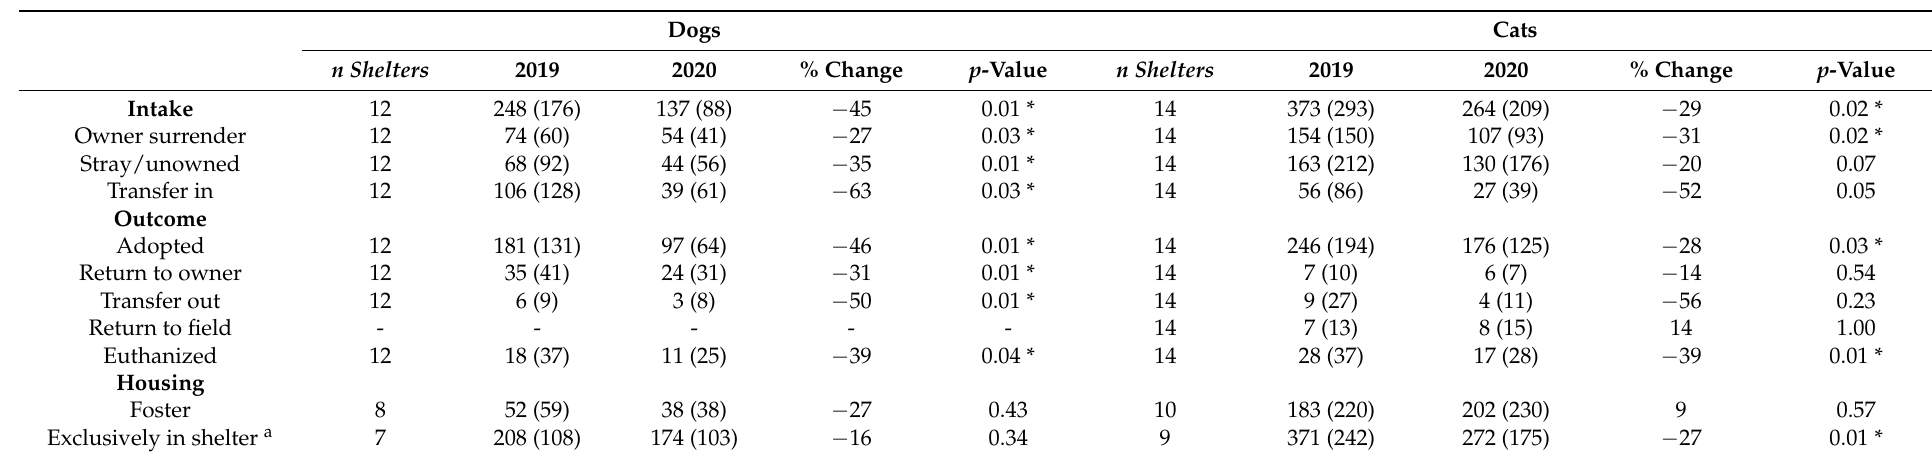
Table 2. Intake and outcome data for March–June 2019 and